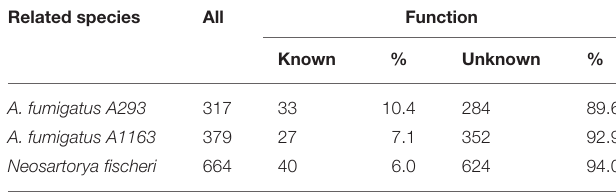
Consult Table S4 for a itemized list of GMs.